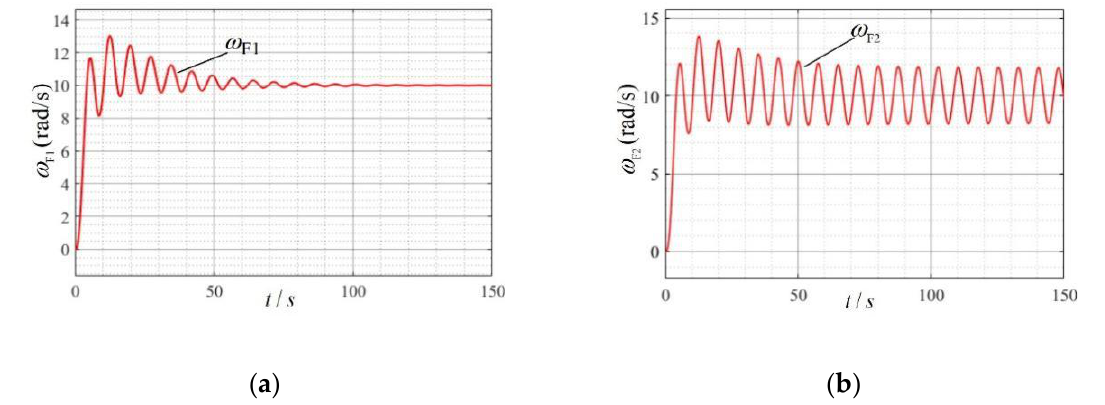
Figure 5. Vibration and suppression of the two-mass wind drivetrain with clearance: ( a ) vibration and elasticity suppression; ( b ) vibration of the gear clearance.